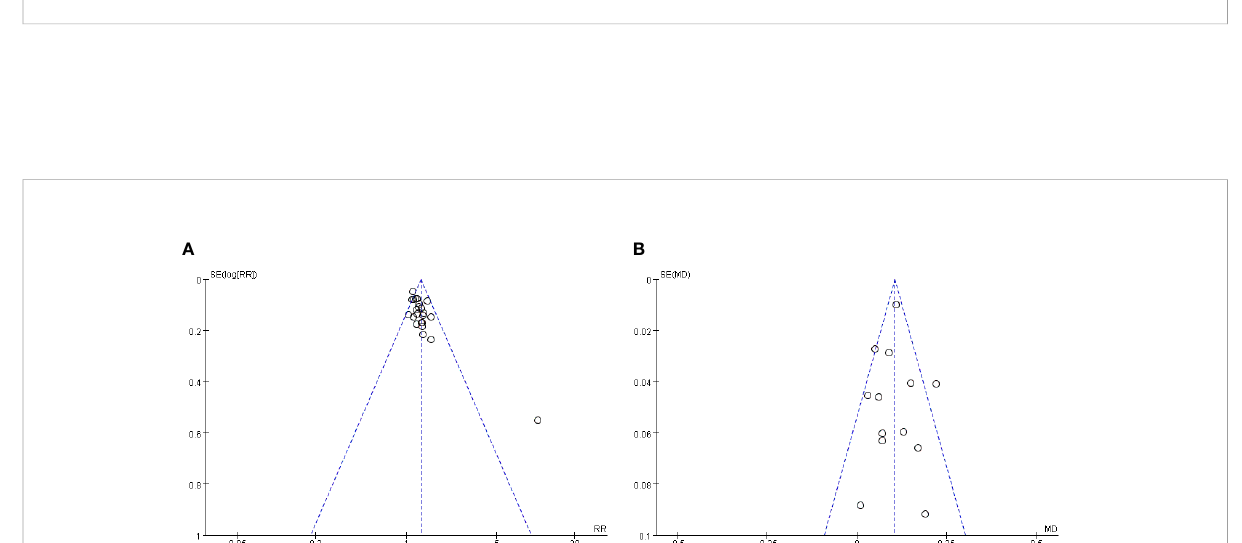
FIGURE 9 Forest plot of comparative adverse reactions.